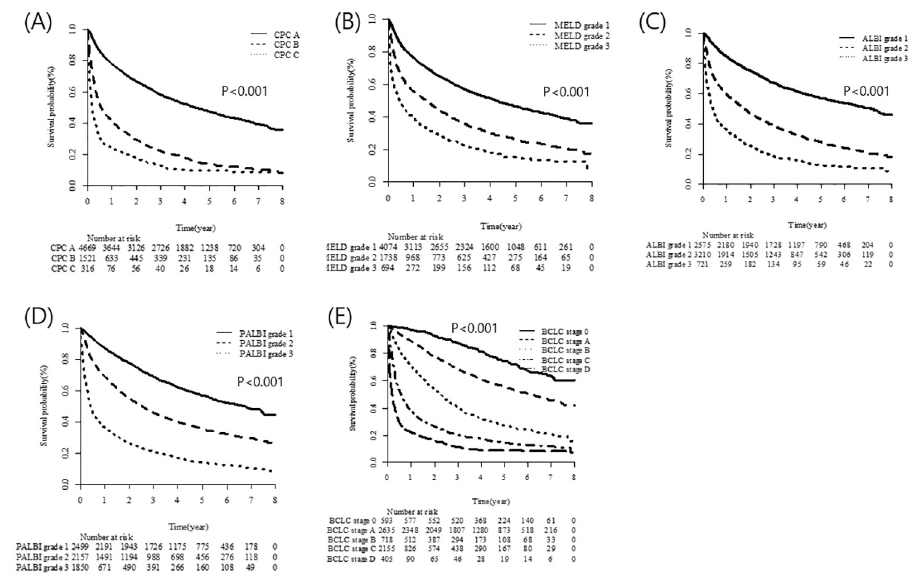
Fig 2. OS stratified by liver function assessment grade and BCLC stage.